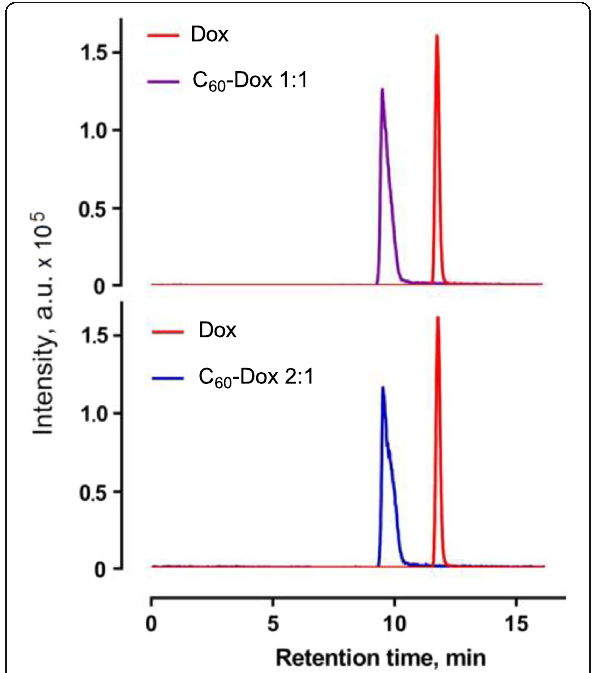
Fig. 1 Multiple reaction monitoring chromatograms of free Dox (1 μ M), C 60 -Dox 1:1 and C 60 -Dox 2:1 (1 μ M Dox-equivalent concentration) complexes under isocratic flow (acetonitrile, 0.1% formic acid in H 2 O, 80:20, v : v ), precursor → product ions transition: 544.2 → 130.2 and 361.1 m/z; a.u. arbitrary